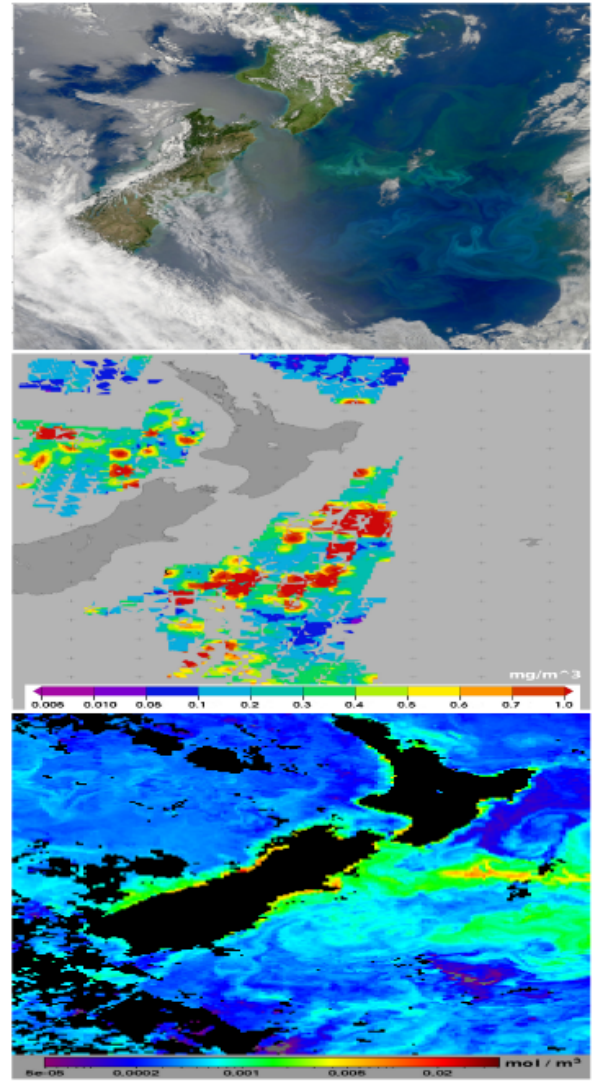
Fig. 11. A case study of phytoplankton bloom detection by PhytoDOAS: the upper panel is a true-color image of MODIS sen- sor (reported by NASA on 23rd December 2009) showing a coc- colithophore bloom near Chatham island, on the eastern side of New Zealand. The middle panel depicts the PhytoDOAS retrieval of the coccolithophore chl a for the same region over a period of two weeks (centered at 23 December 2009). The lower panel illus- trates the distribution of MODIS-Aqua PIC for the bloom region as an 8-date composite (19 to 26 December